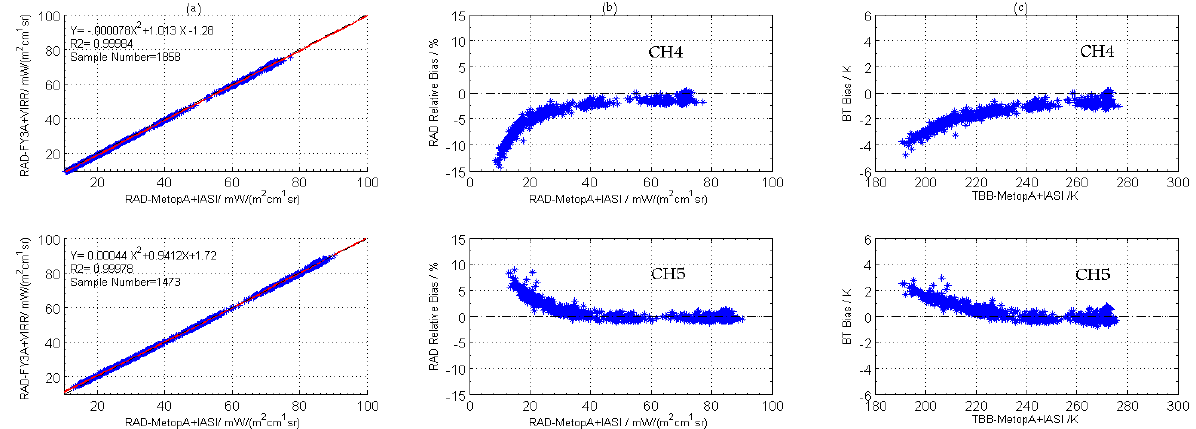
Figure 7. Radiance comparison between FY-3A/VIRR and METOP-A/IASI ( a ); as well as their observation differences (VIRR-IASI) in radiance ( b ) and BT ( c ) using collocation samples in August 2012. The red lines are quadratic fitting results. The top plots are for CH4, and those on the bottom are for CH5.